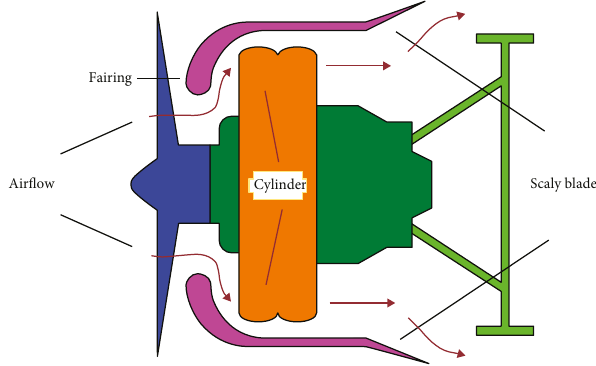
Figure 4: Working principle diagram of UAV recti fi er